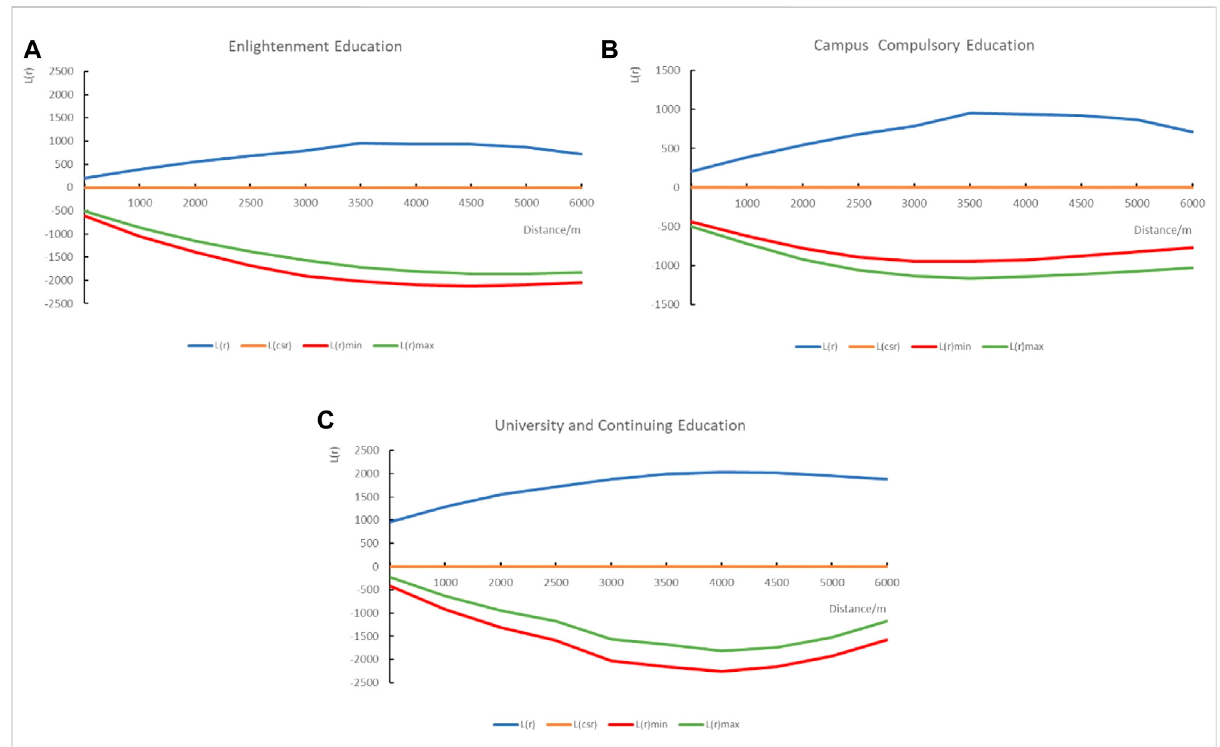
FIGURE 3 Results of Ripley ’ s L(r) function. (A) Enlightenment Education, (B) Campus Compulsory Education, (C) University and Continuing